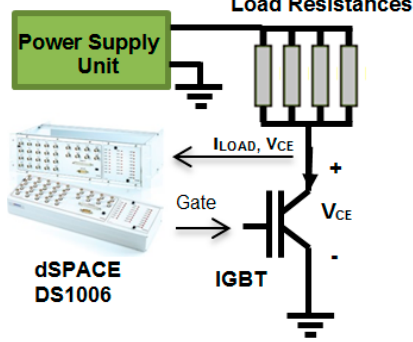
Figure 18. Accelerated life consumption test set-up.